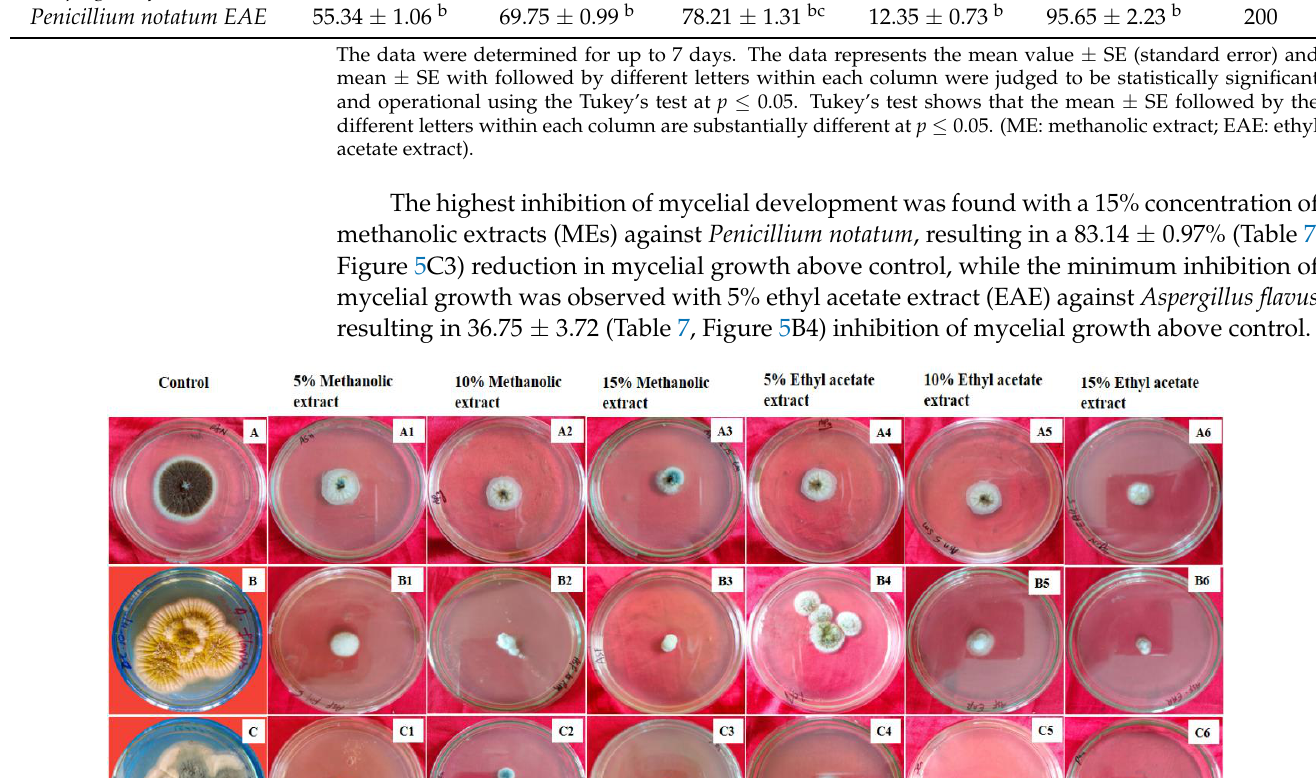
Table 7. Antifungal activity (percentage mycelial inhibition) of rhizome extracts of A. chasmanthum .